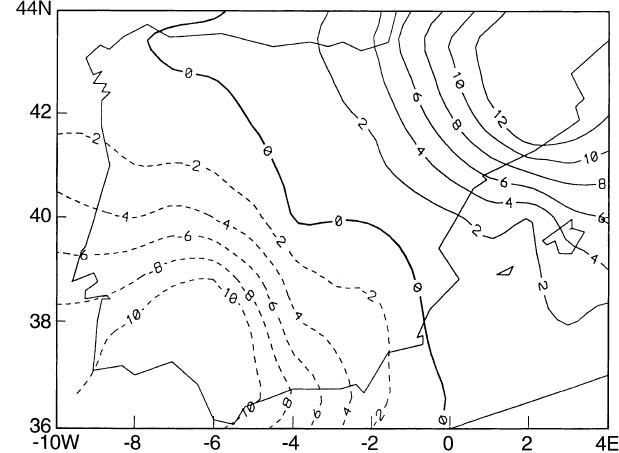
Fig. 5. Isohyets of daily rainfall (mm) for 15 March 1990